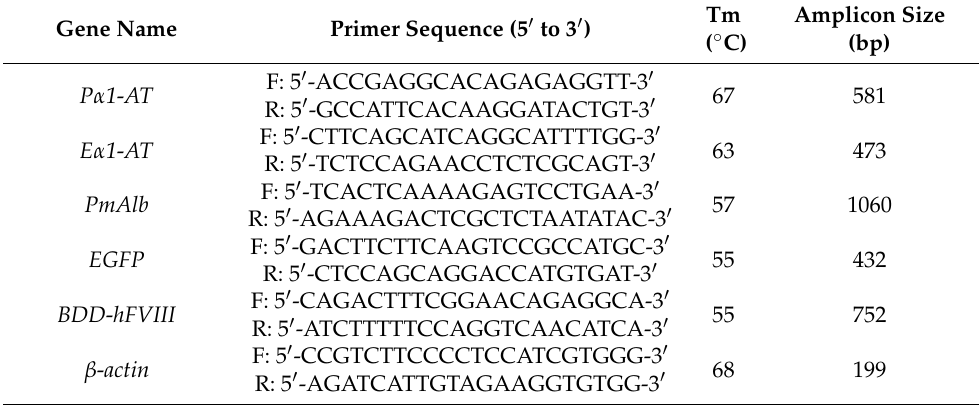
Table 1. Information on the PCR or RT-PCR primers used in this